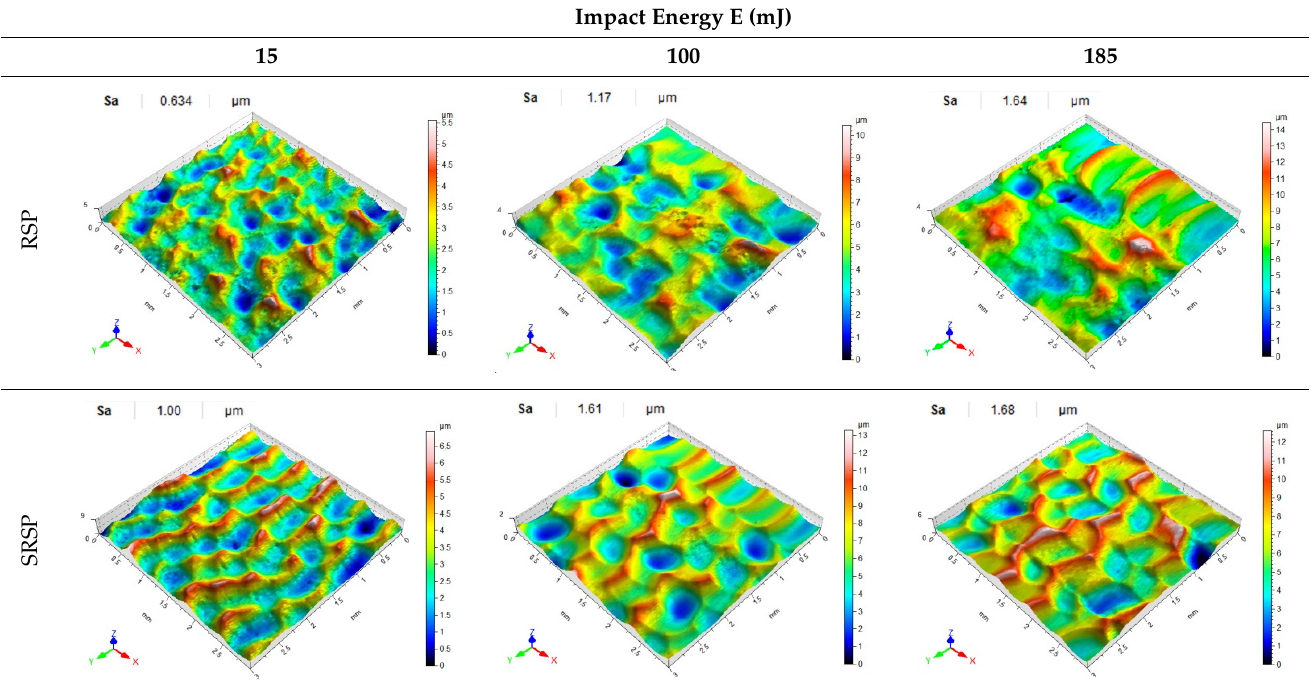
Table 8. Effect of impact energy on the Sa roughness parameter and surface topography (ball diameter D = 10 mm, distance between dimples x = 0.3 mm).